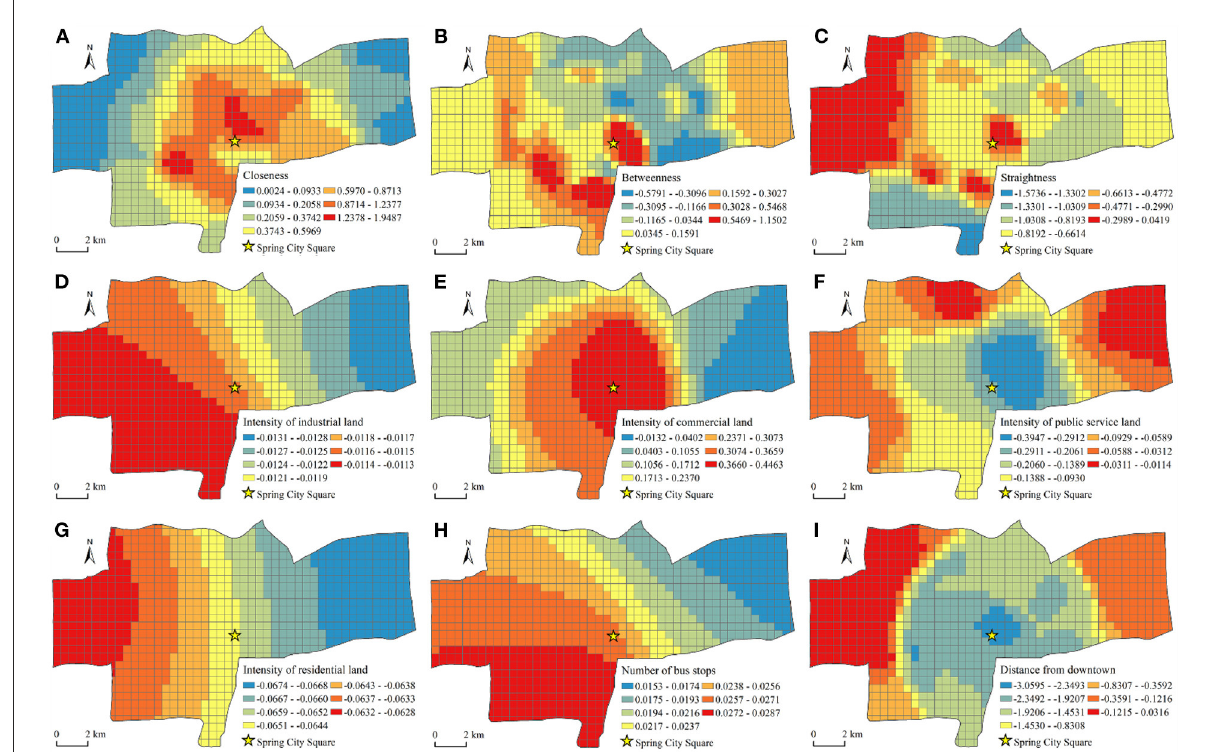
FIGURE7 Spatial pattern of expression coefficients of MGWR variables in the driving mode. (A) Closeness. (B) Betweenness. (C) Straightness. (D) Intensity of industrial land. (E) Intensity of commercial land. (F) Intensity of public service land. (G) Intensity of residential land. (H) Number of bus stops. (I) Distance from